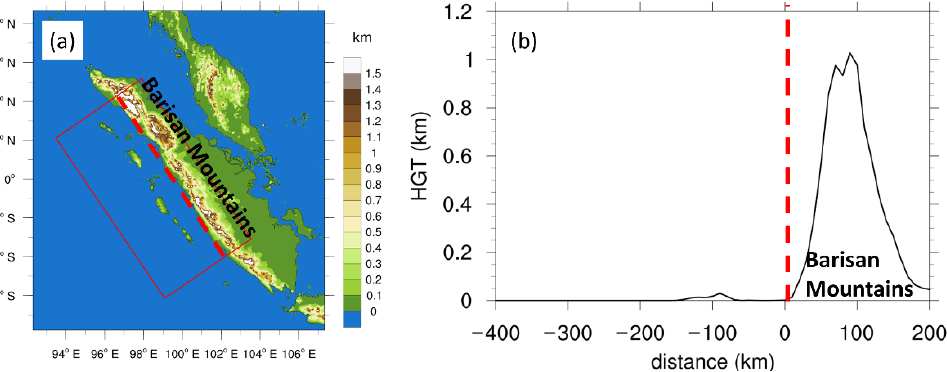
Figure 1. ( a ) The spatial distribution and ( b ) the vertical cross section (perpendicular to the coast) of topography (km) near western Sumatra coast. The red solid box is used for all the Hovmöller diagrams in this paper, with the distance ranging from − 400 km offshore to 200 km onshore. The red dashed line marks the location of western coast with the distance of 0 km in ( b ).